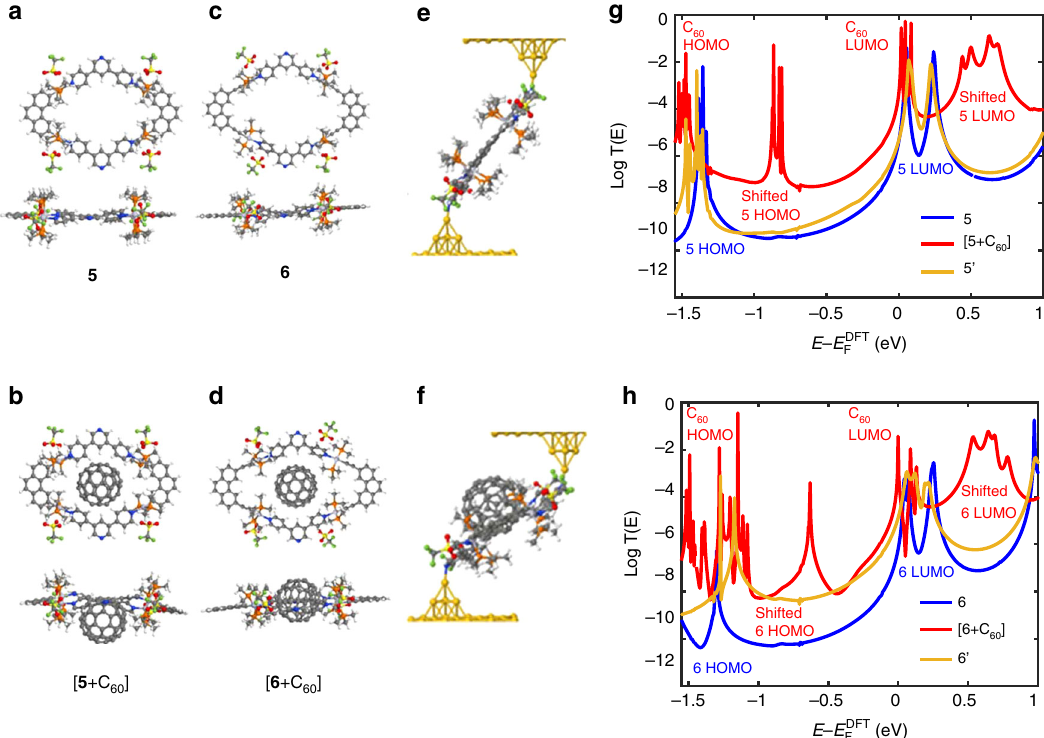
Fig. 5 Gold/molecule/gold junctions quantum calculations. Top and lateral views of metallocycle cation with -OTF anions (CF 3 SO 3 − ). a for 5 , b for [ 5 + C 60 ], c for 6 , d for [ 6 + C 60 ]. Single-molecule junctions containing CF 3 SO 3 − anions, where the terminal atom of the gold tip is bonded above and below to the nitrogen atom of the pyridine with a Au – N distance of 2.3 Å. e for 5 , f for [ 5 + C 60 ] where the angles between the Au – N bond formed by electrode- apex Au and N of the connected anchor pyridine and pi-orbital of this pyridine are around 45° and 65°, respectively after geometrical optimization. Quite similar junction geometries for 6 and [ 6 + C 60 ] are not shown which could be found in Supplementary Fig. 42. Gold atoms in the electrodes are colored yellow. In the molecule, gray, blue, and white represent carbon, nitrogen, and hydrogen atoms; green, light yellow, red, large grep, and orange represent fl uorine, sulfur, oxygen, platinum, and phosphorus atoms. g , Transmission functions of 5 , [ 5 + C ′ ) which is obtained 60 ] and the distorted 5 (denoted as 5 from the junction of [ 5 + C 60 ] by removing C 60 . h , Transmission functions of 6 , [ 6 + C 60 ] and the distorted 6 (denoted as 6 ′ ) which is obtained from the junction of [ 6 + C 60 ] by removing C 60 . The resonances of red curve are labeled by red words while the blue curve correspond to blue words. Corresponding room temperature electric conductances are shown in Supplementary Fig.